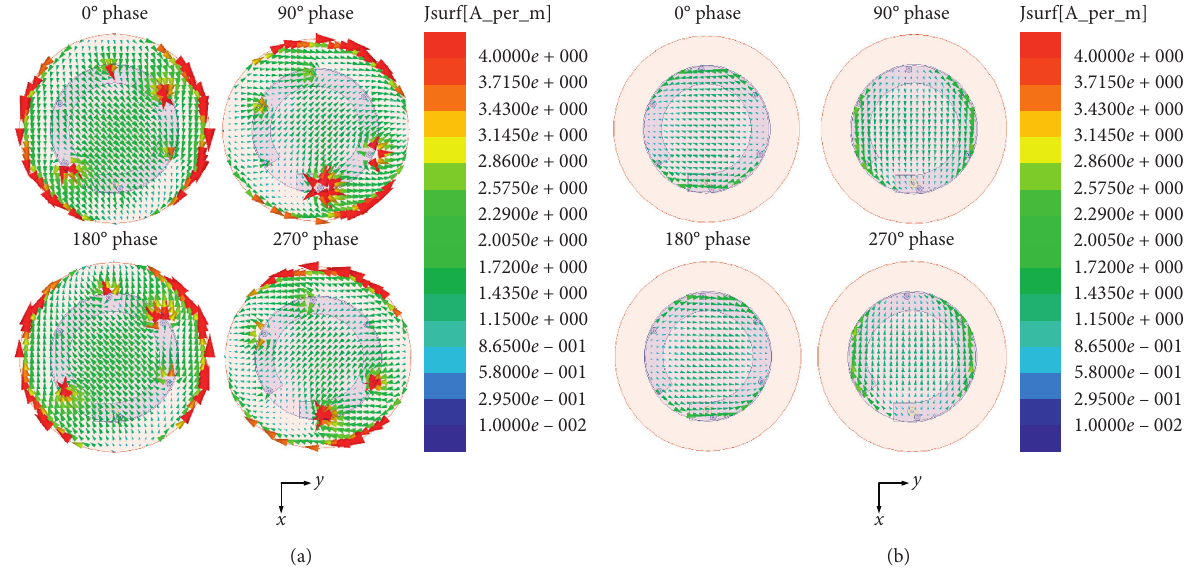
Figure 12: The surface current distribution on (a) patch 1 and (b) patch 2 at 1.91GHz.